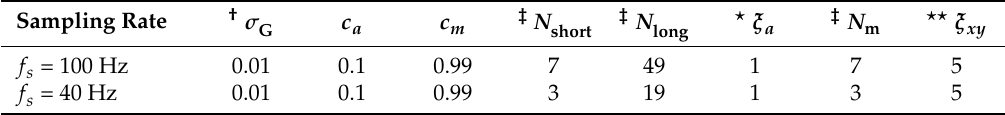
Table 1. Tuning parameters of the computationally-efficient adaptive error-state kalman filter. Sampling